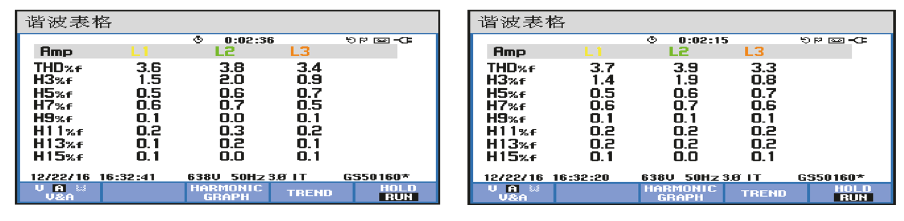
Figure 12: Harmonic characteristic comparison.